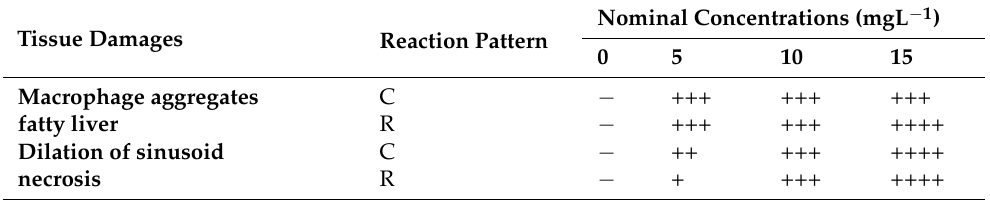
Table 5. Liver damages of Capoeta ( Capoeta capoeta ) 96 h after exposure to different levels of Ag-NPs. Tissue